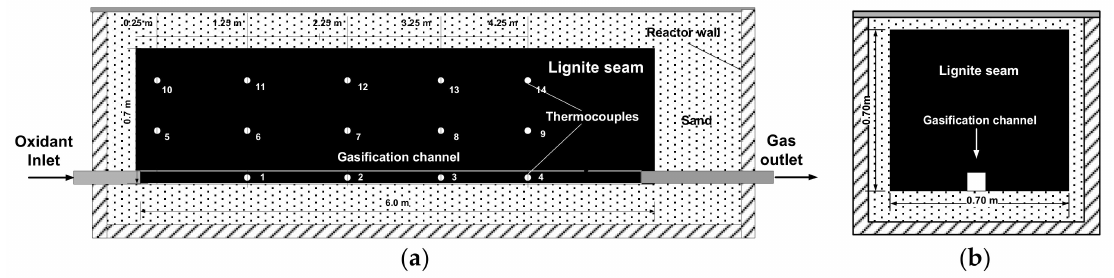
Figure 5. Sections of the artificial coal seam (proportions are not respected): ( a ) longitudinal ( b )